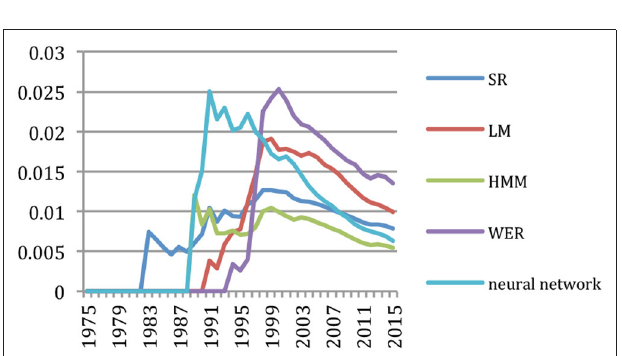
F. Soong, of important contributors in an early stage such as